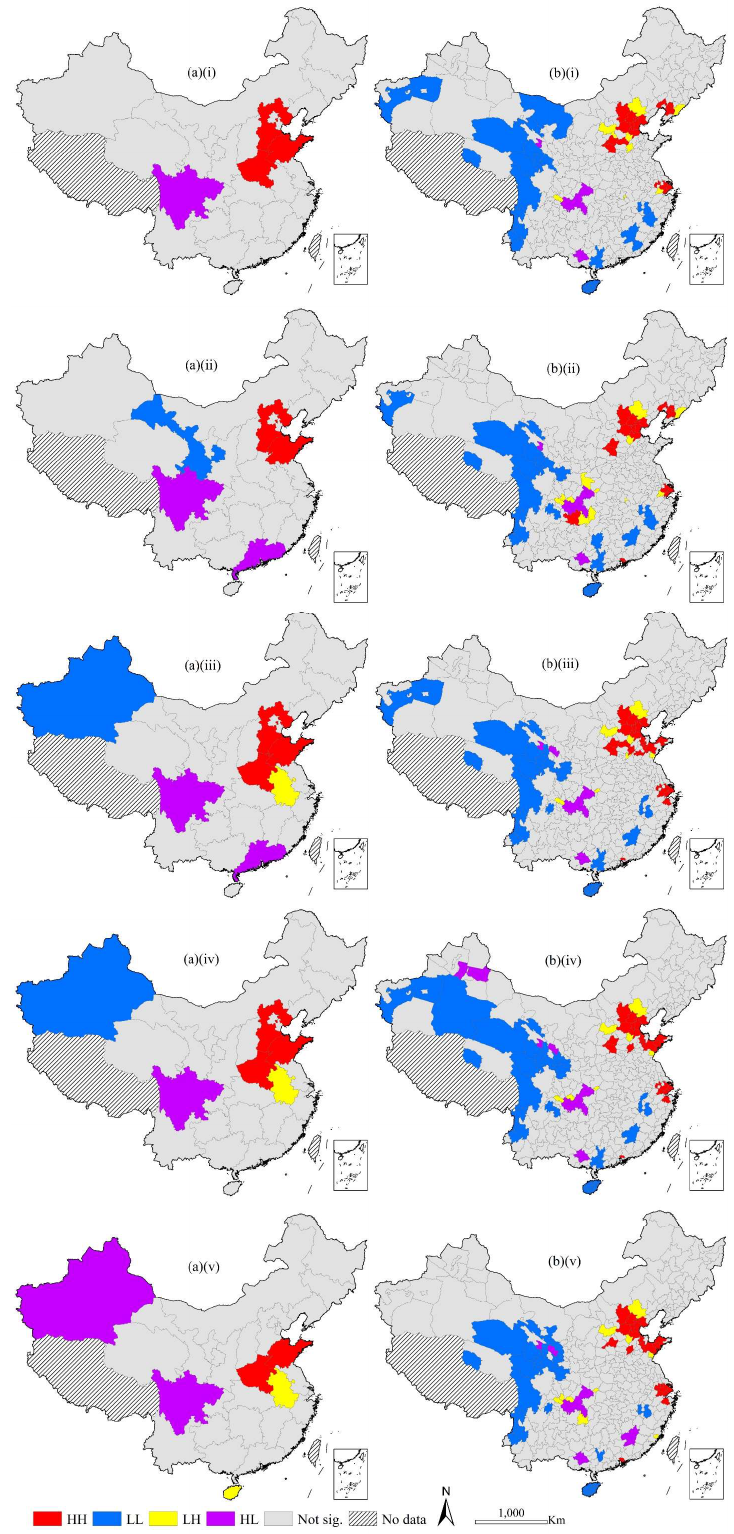
Figure 7. Spatial clusters for energy consumption on the ( a ) provincial level and the ( b ) prefectural level in (i) 1995, (ii) 2000, (iii) 2005, (iv) 2010, and (v)